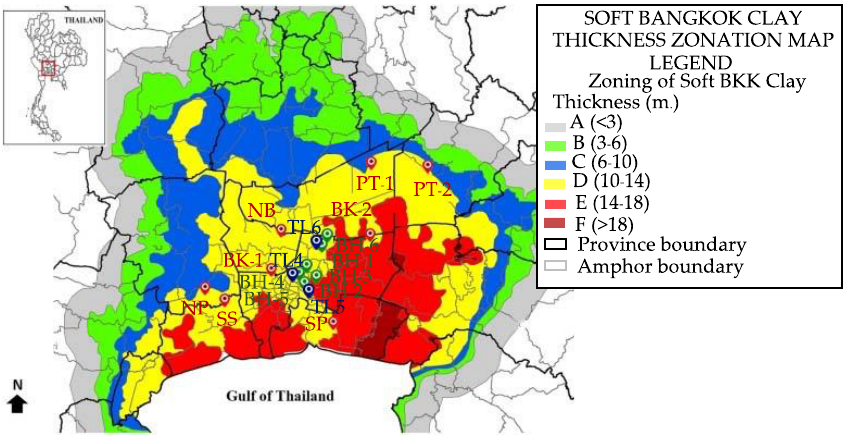
Figure 2. Locations of the studied holes. Table 2. Name and location of each bored hole on the map.